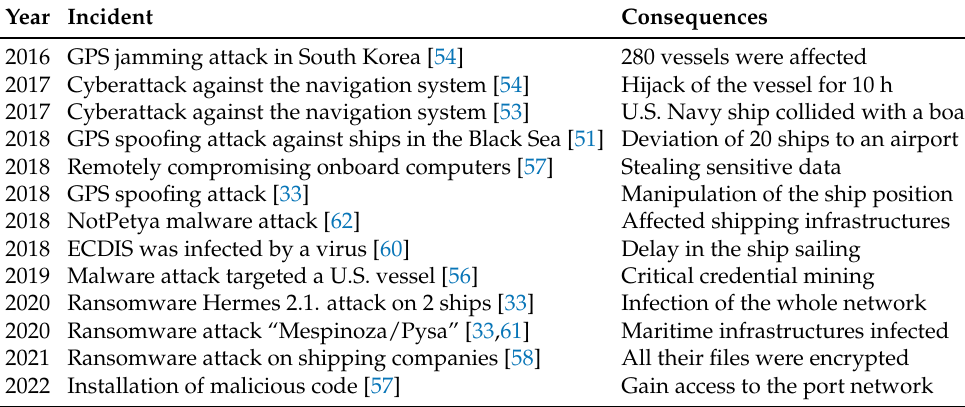
Table 3. Examples of recent cyber incidents in the maritime transport